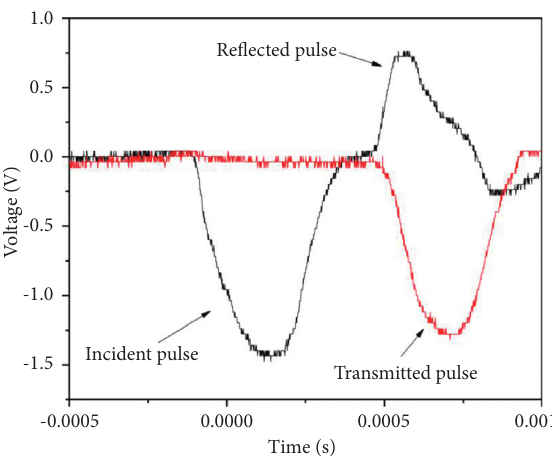
Figure 4: Recorded waveforms from dynamic compression